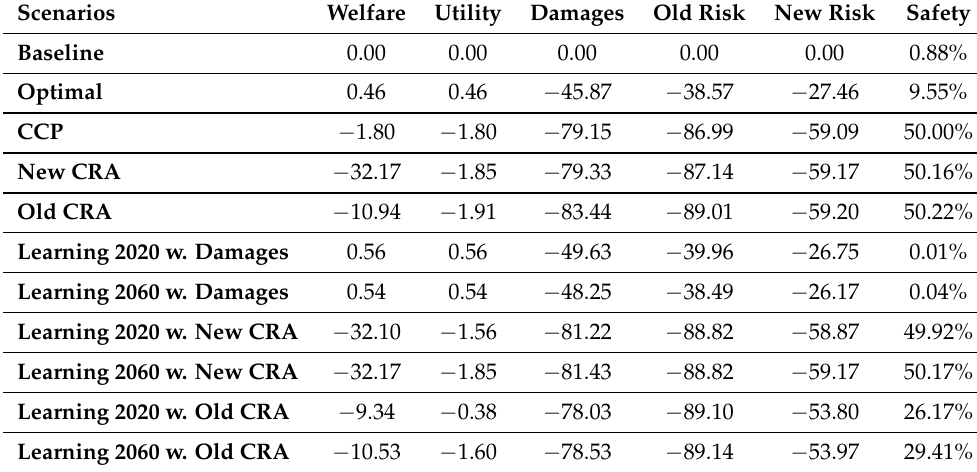
Table 1. Safety and percentage changes of the expected value of welfare, utility, damages, old risk, and new risk for all the